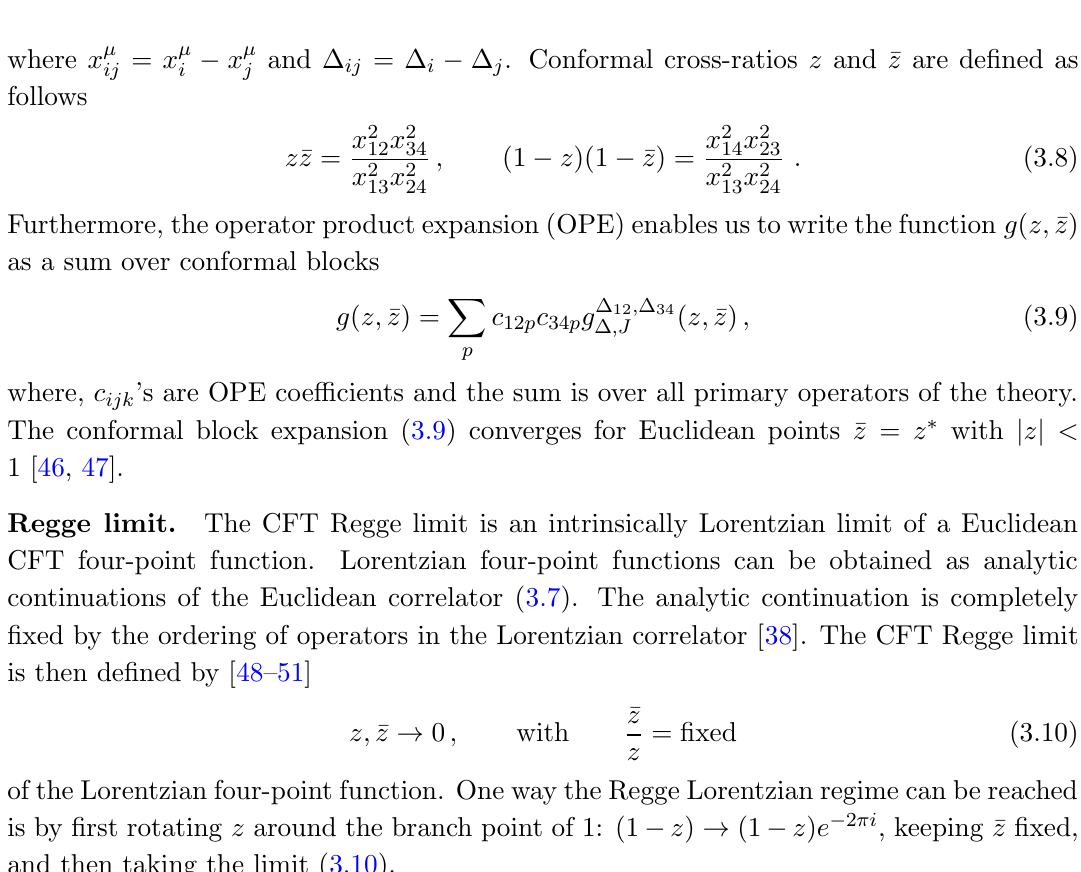
Figure 3 . A Lorentzian four-point function where all points are restricted to a 2d subspace. Null coordinates are de(cid:12)ned as x (cid:6) = x 0 (cid:6) x 1 , where x 0 is running upward. In the regime 0 < (cid:26); (cid:22) (cid:26) < 1, this correlator is given by the Euclidean four-point